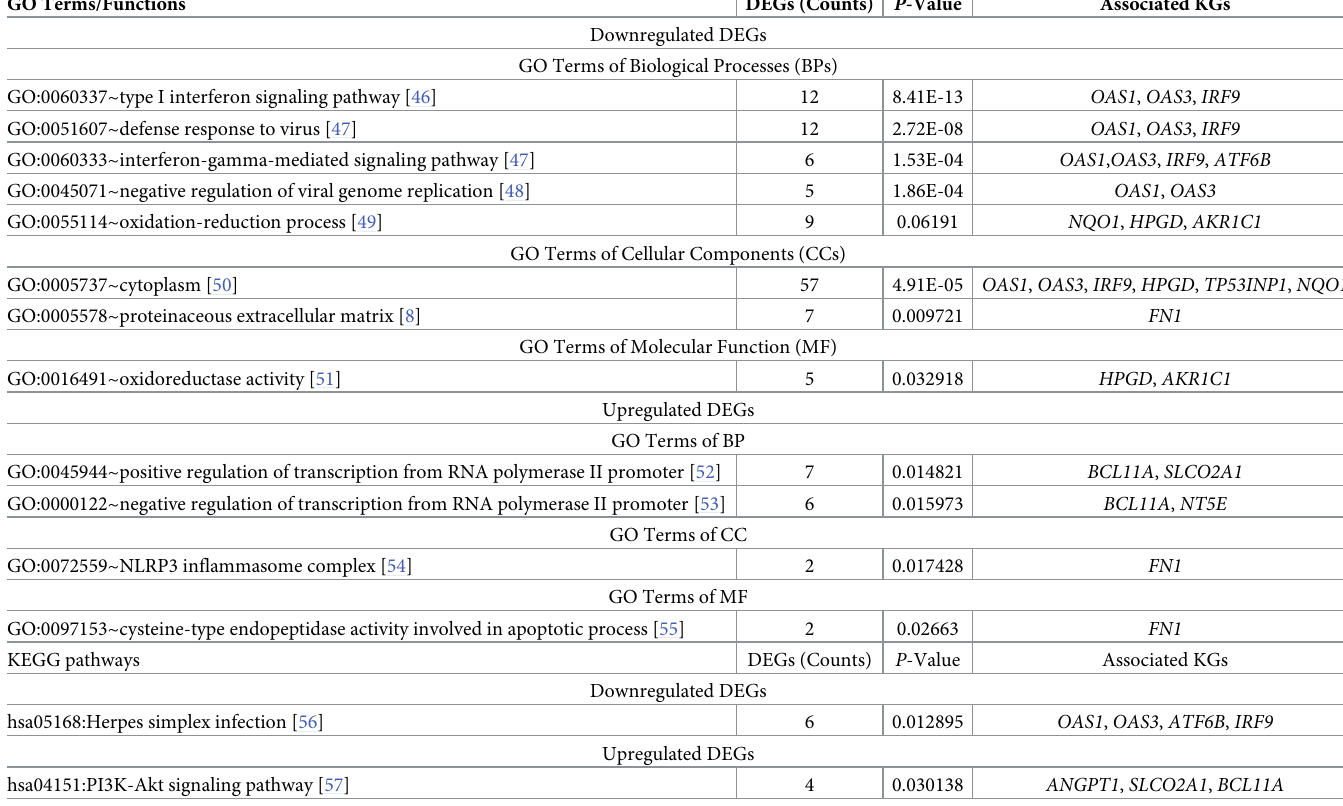
Table 3. Significantly enriched GO functions and KEGG pathways by the DEGs involving KGs that were also supported by the literature review about their associa- tion with BC and other cancers. GO